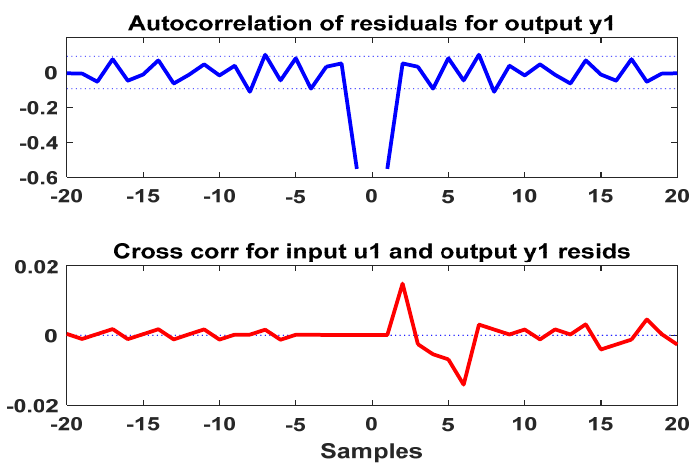
Figure 6. Model residual.